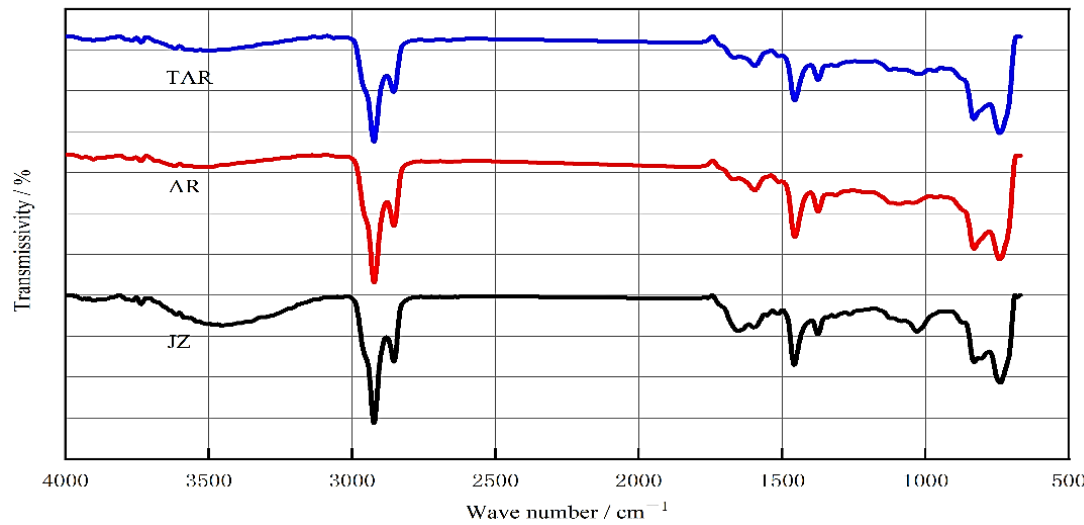
Figure 25. Infrared spectrum diagram of three kinds of asphalts.